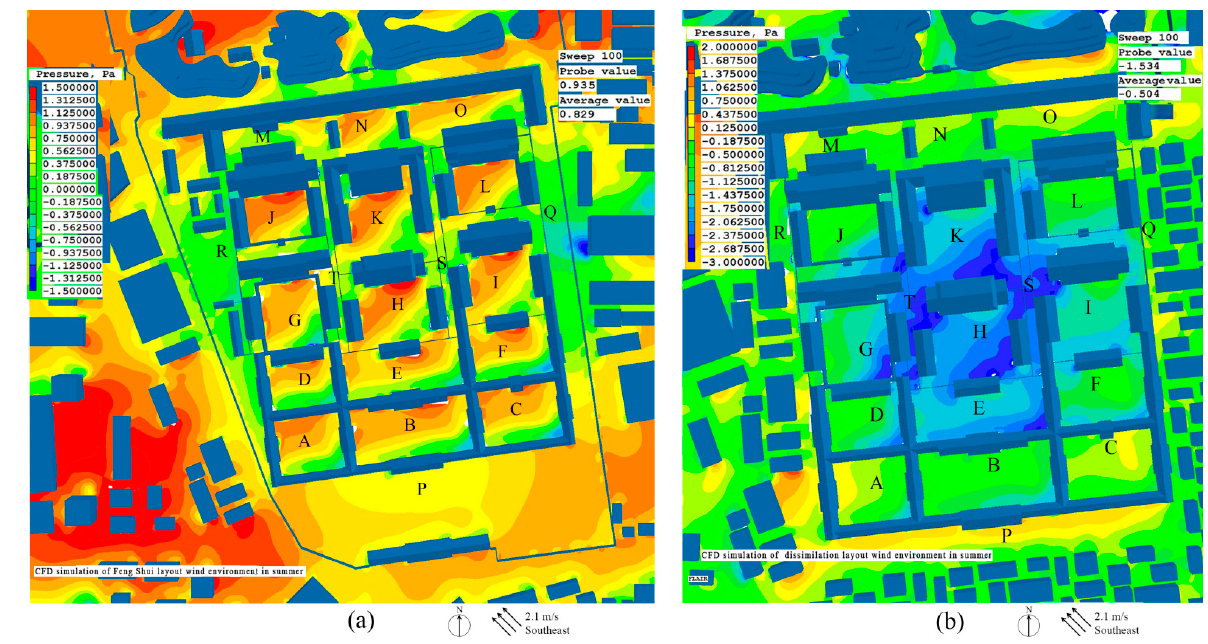
Figure 13. ( a ) Wind pressure cloud of feng shui layout in summer. ( b ) Wind pressure cloud of dissimilation layout in summer. The figures were obtained by CFD simulation.